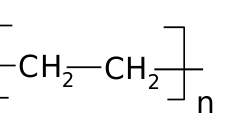
Figure 1. The fragment of polyethylene structure.